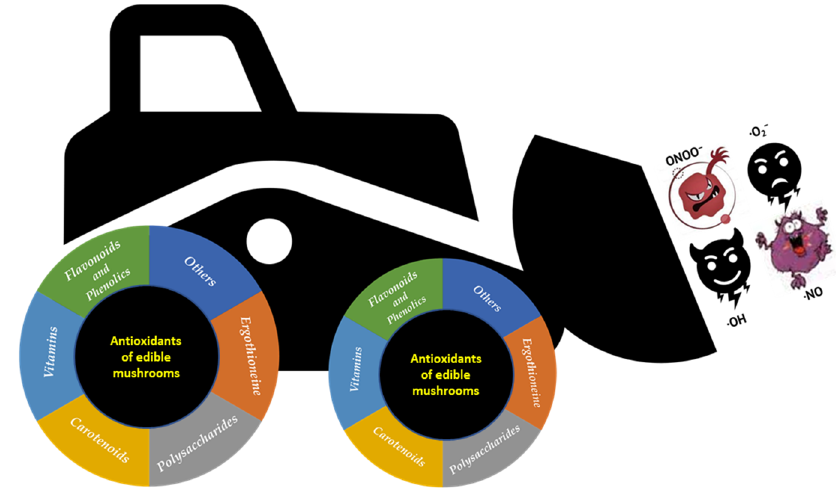
Figure 2. The antioxidant mycochemicals of edible and medicinal mushrooms.